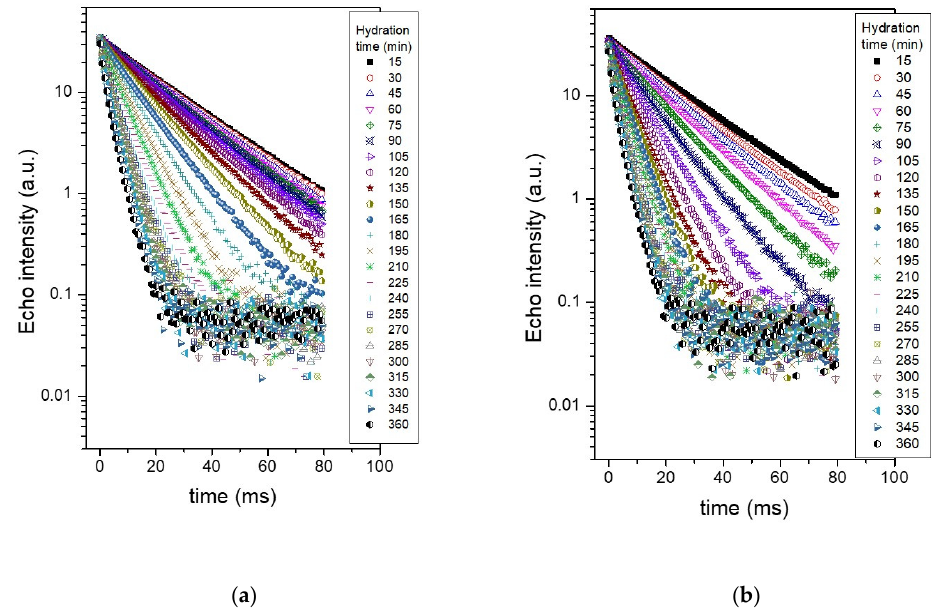
Figure 1. CPMG echo trains recorded for the two samples, at different hydration times, as indicated in the legend: ( a ) Cement paste sample prepared at a water-to-cement ratio of 0.4. ( b ) Cement paste prepared at 0.4 water-to-cement ratio which additionally contains 3% accelerator (Ca(NO 3 ) 2 ).